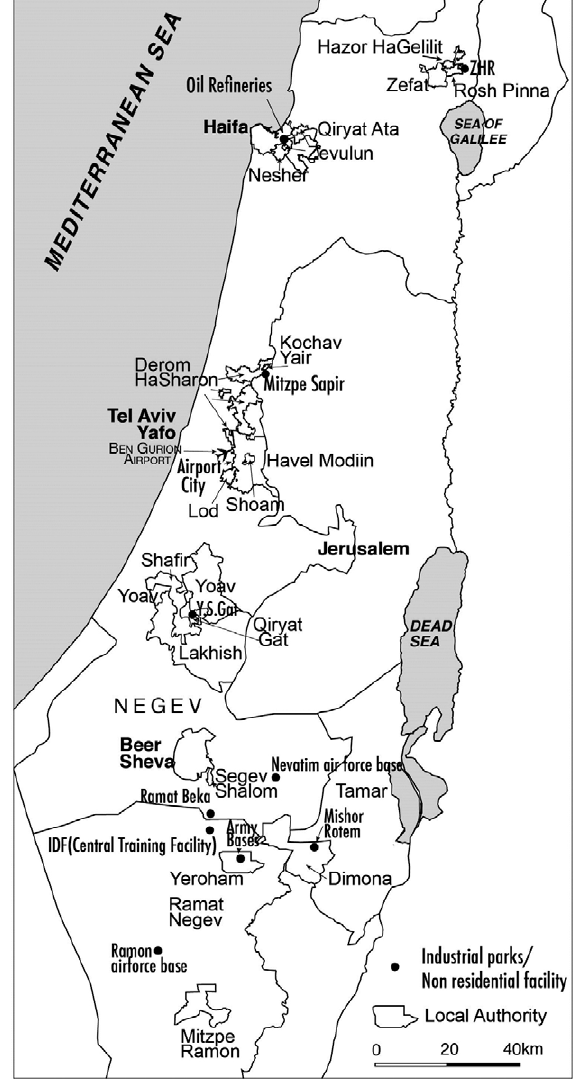
Fig. 1. Selected revenue redistribution areas and the local authorities involved (2014